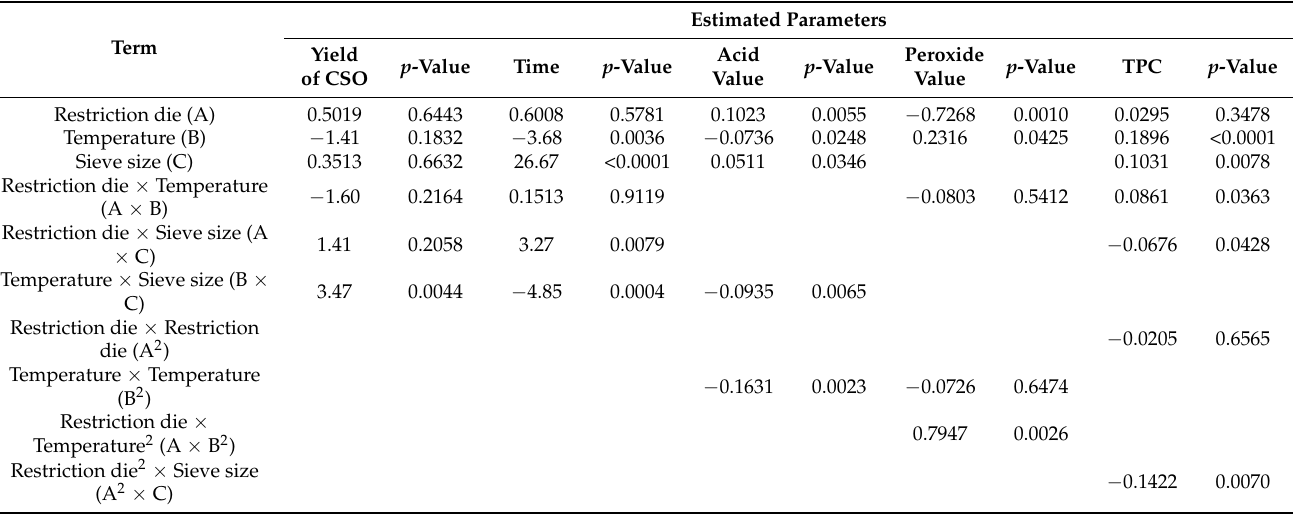
Table 4. Estimated Parameters for CSO extraction and other